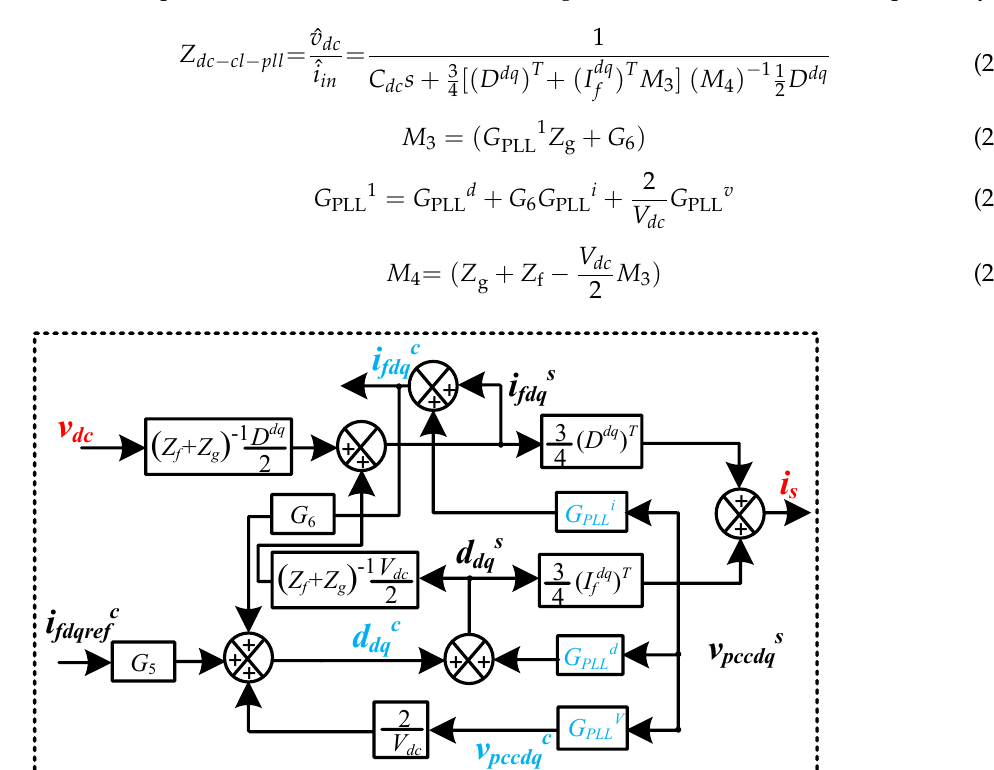
Figure 4. Small signal impedance model of GC operating in closed loop current control with consid- eration of PLL